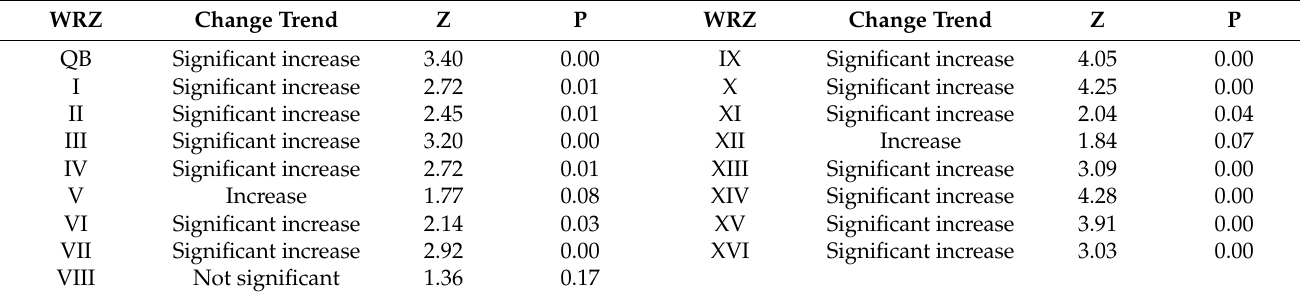
Table 4. Test results of the trend test of precipitation in the Qaidam Basin from 1990 to 2020.